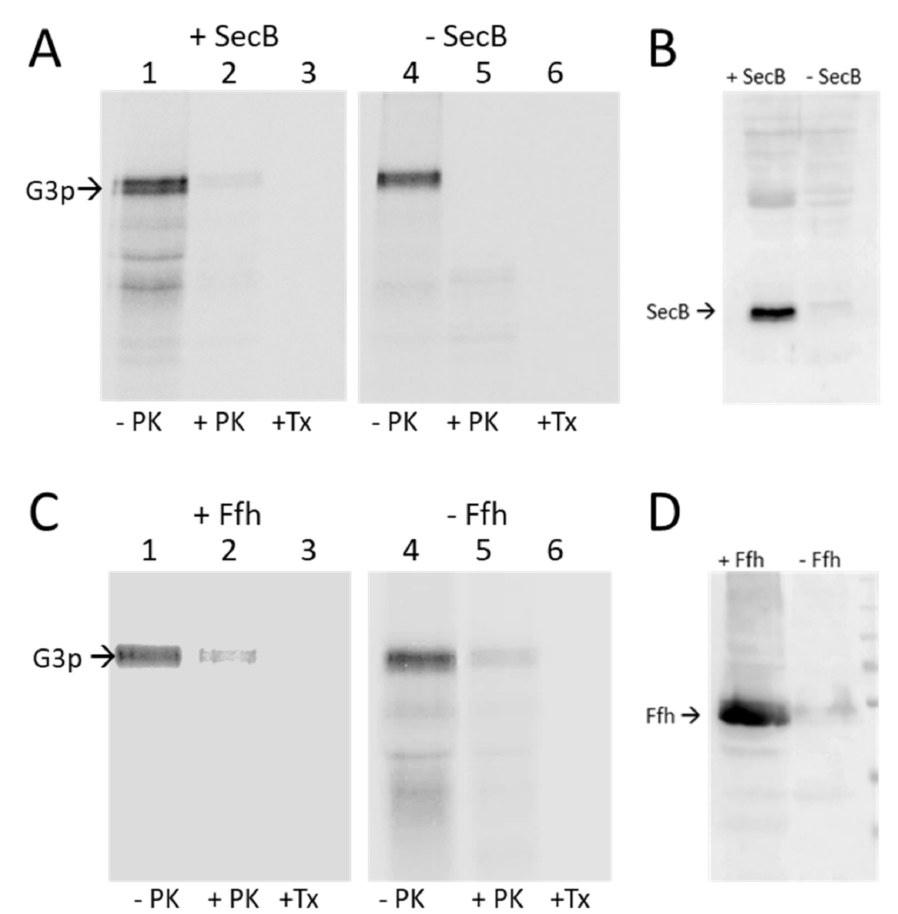
Figure 2. Targeting of G3p is independent of SecB and SRP. ( A , B ) The plasmid encoding G3p was transformed into the SecB deletion strain JW3584. ( A ) Exponentially growing cells were induced for 10 min with 1 mM IPTG, pulse labelled with 35 S-methionine/cysteine for 3 min and converted to spheroplasts (-PK). A portion was digested with proteinase K (+PK) or with proteinase K in the presence of Triton-X-100 (+TX). The samples were immunoprecipitated with an M13 antibody and analysed by PAGE and phosphorimaging. ( B ) Western blot of the JW3584 culture and the control strain MC1061 detecting SecB. ( C ) The araBAD-controlled MC-dFfh strain was used to determine the requirement of SRP for the membrane insertion of G3p. The cells were grown either in the presence of arabinose (+Ffh) or in the absence of arabinose (-Ffh) and treated as described in ( A ). ( D ) Western blot to evaluate the cellular Ffh content in the culture grown with or without arabinose,